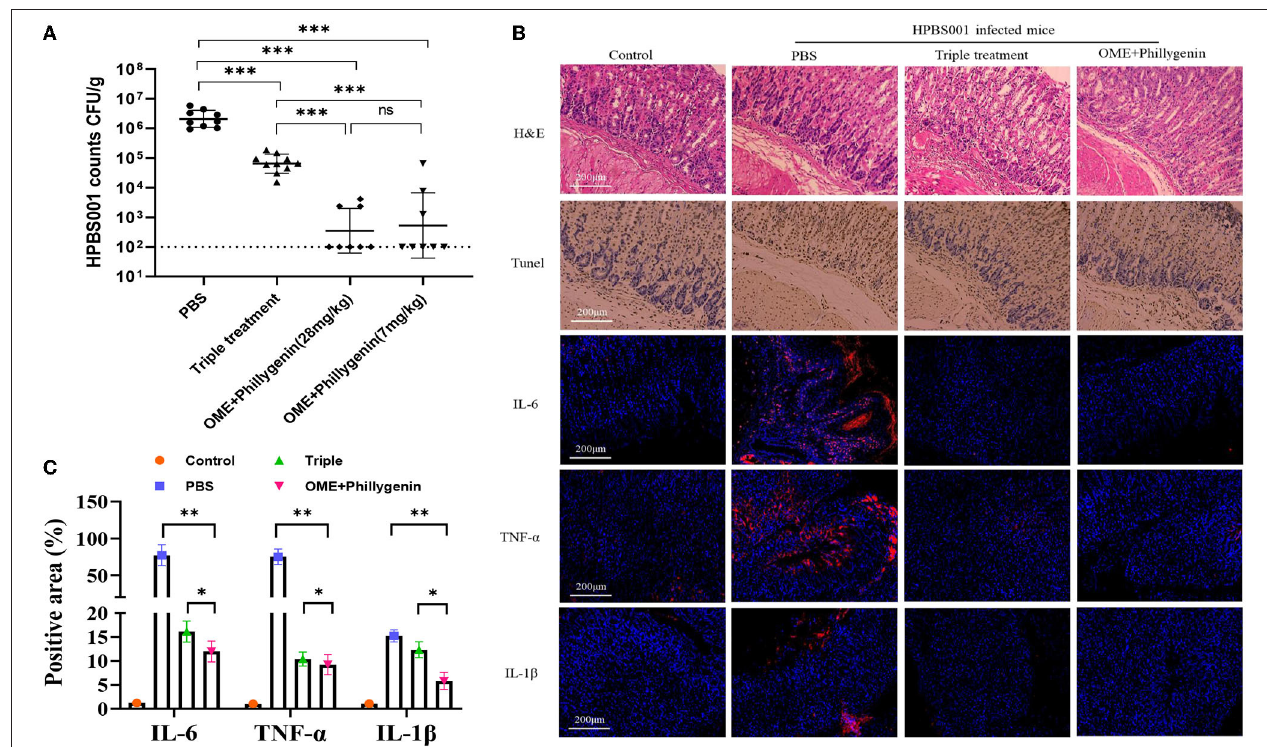
FIGURE 3 | Evaluation of the antibacterial effect of phillygenin in mice. (A) Presents the amount of HPBS001 colonization of mice with acute gastritis; (B) displays the repair of gastric mucosal tissues of mice with acute gastritis; and (C) shows the quantitative graph of inflammatory factors. ns P > 0.05, * P < 0.05, ** P < 0.01, ***P <